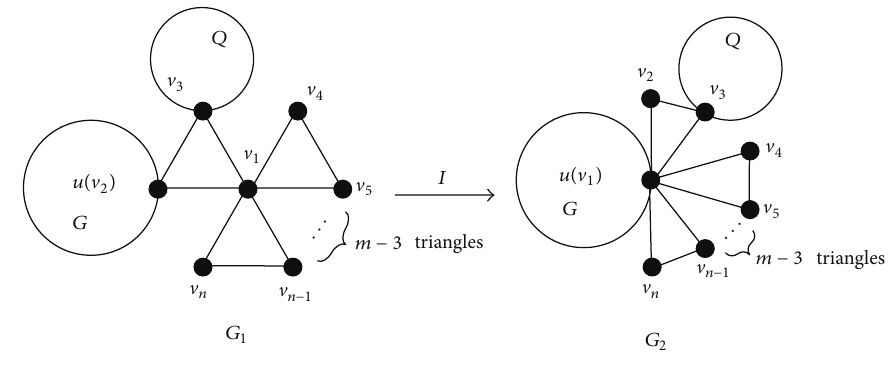
Figure 3: Transformation 𝐼